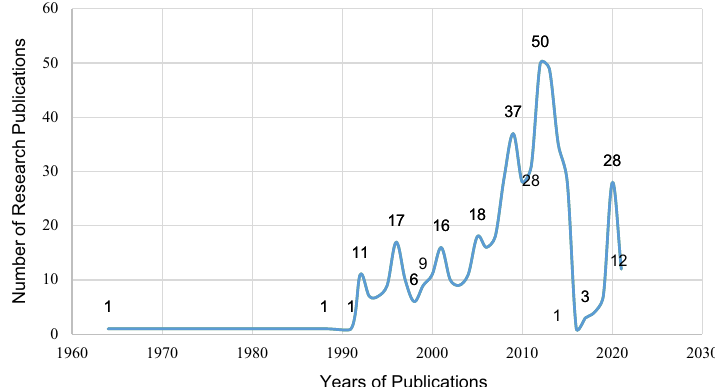
Fig. 3 Number of research publications related to textbooks for learners of English per year – a diachronic